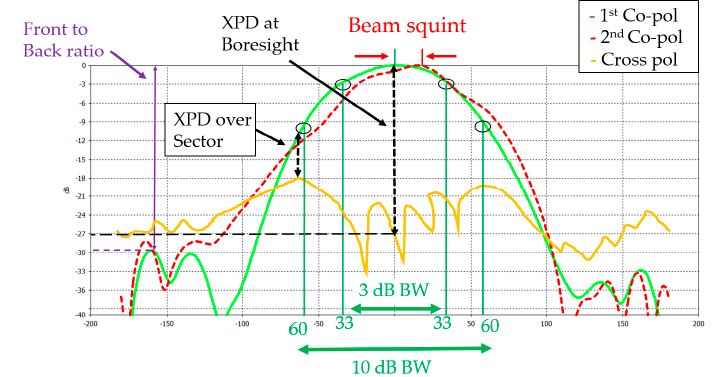
Figure 11. Illustration of some critical parameters for antenna radiation pattern. The beamwidths 3 dB and 10 dB are important in network planning to mark sector footprints. Usually, single beam/sector antennas must have an HPBW requirement of 65 ◦ for three sector cell sites and 45 ◦ or 33 ◦ for six sector sites. The 10 dB beamwidth refers to the angular beamwidth at 10 dB below the peak values. It is desirable to have a 10 dB beamwidth of 120 ◦ in a three-sector site which implies that signal strength at the sector edge is 10 dB below the peak in